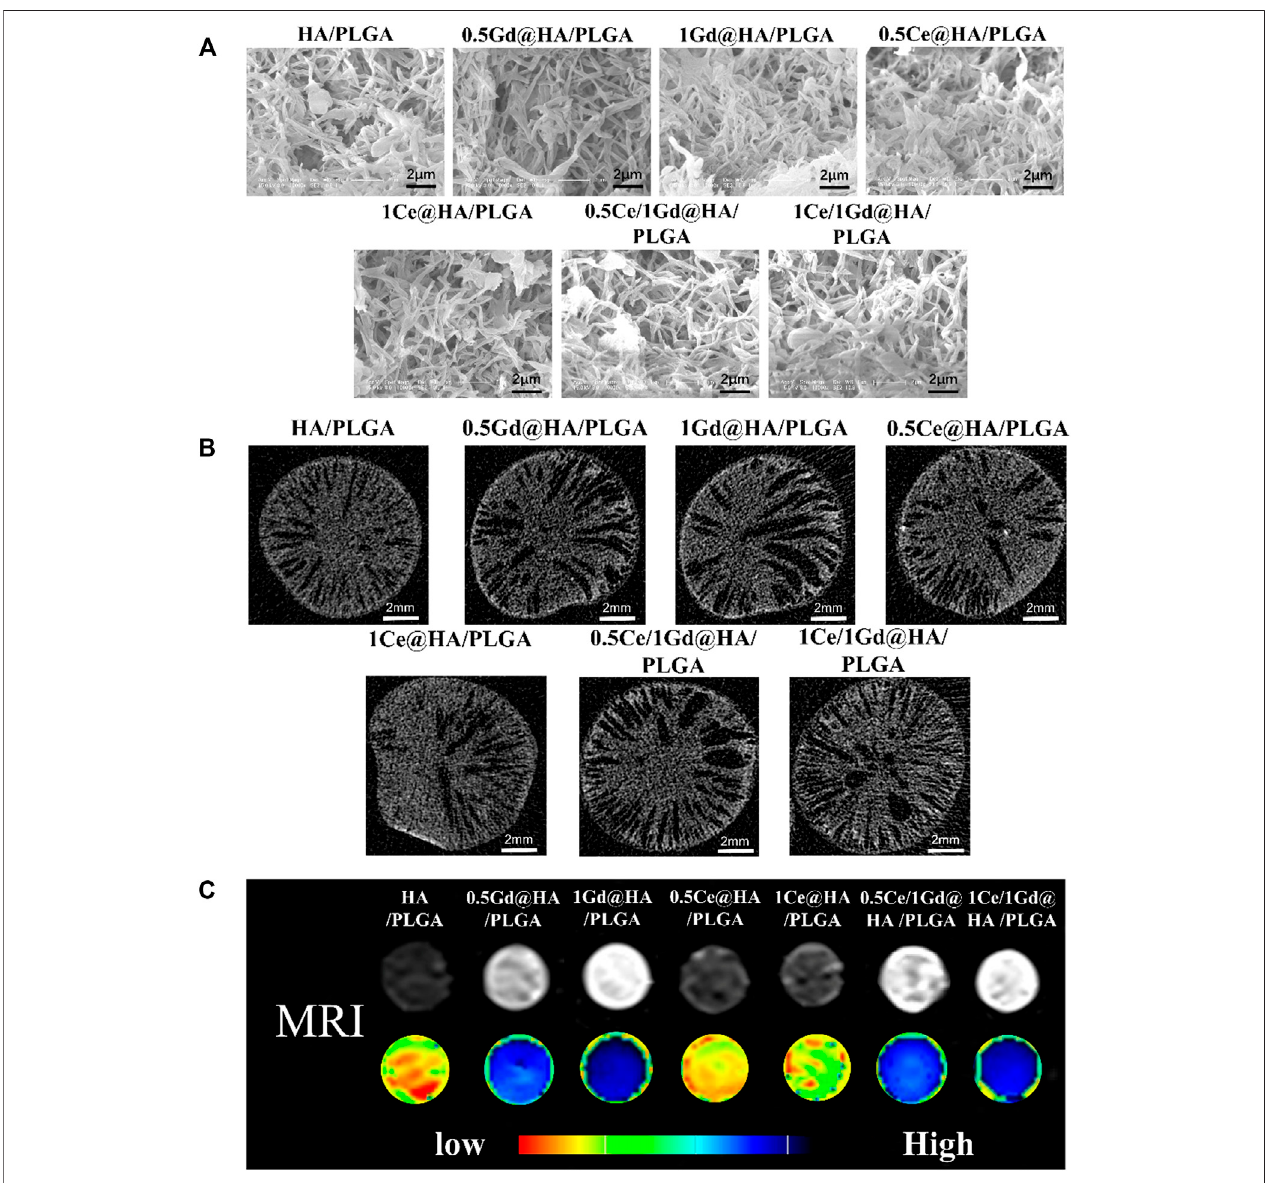
FIGURE 4 | (A) ESEM micrographs of porous scaffolds. (B) Micro-CT axial scanning images, (C) T 1 weighted images, and parametric mapping of HA/PLGA, 0.5Ce@HA/PLGA, 1Ce@HA/PLGA, 0.5Gd@HA/PLGA, 1Gd@HA/PLGA, 0.5Ce/1Gd@HA/PLGA, and 1Ce/1Gd@HA/PLGA.